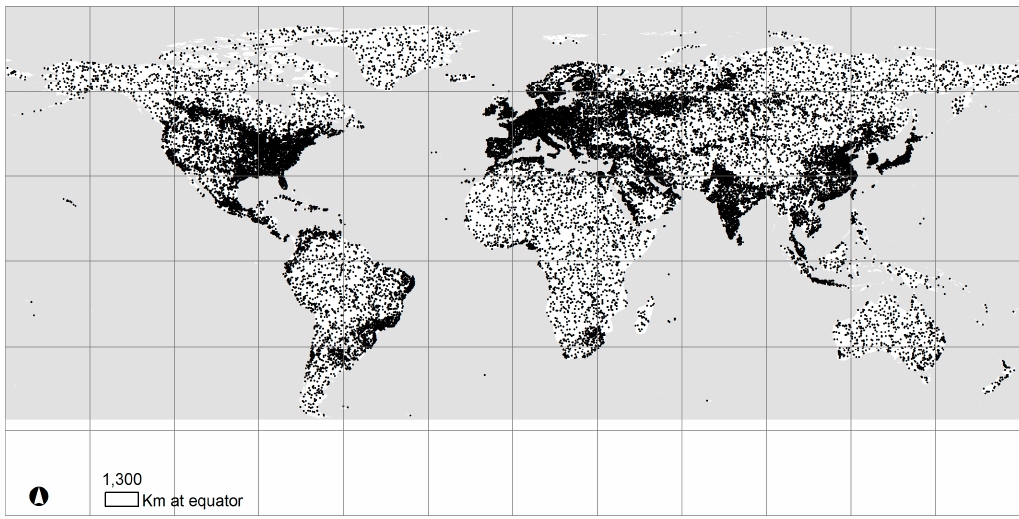
Figure 3. A global sample design of the Global Grid for terrestrial land use/cover, stratified on an urban to rural gradient generated from “nightlights” imagery from 2013.